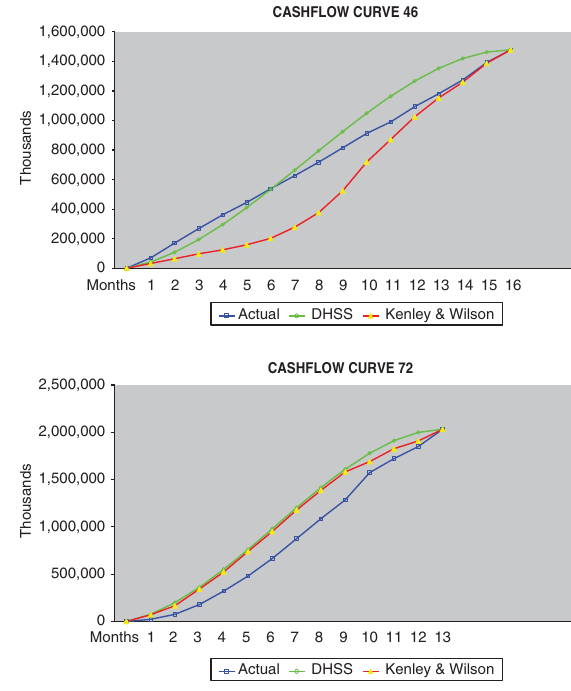
Fig. 7. Cash fl ow curves for projects 12, 46, 66 and 72